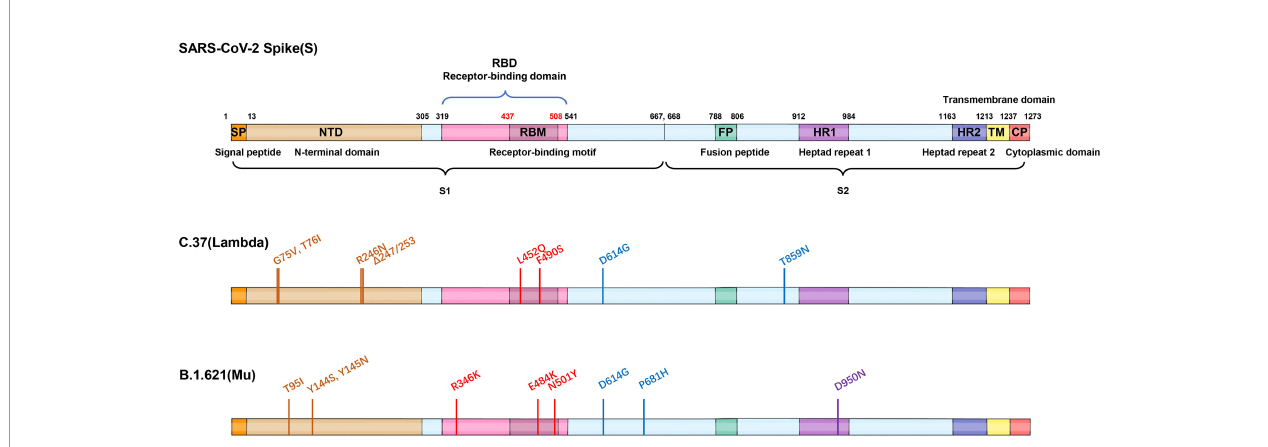
FIGURE 4 | Mutations of two VOI variants. Schematic showing the locations of amino acid substitutions of two VOI variants (C.37 and B.1.621) in spike protein. The RBD region is shown in modena, the NTD region is shown in shallow orange.